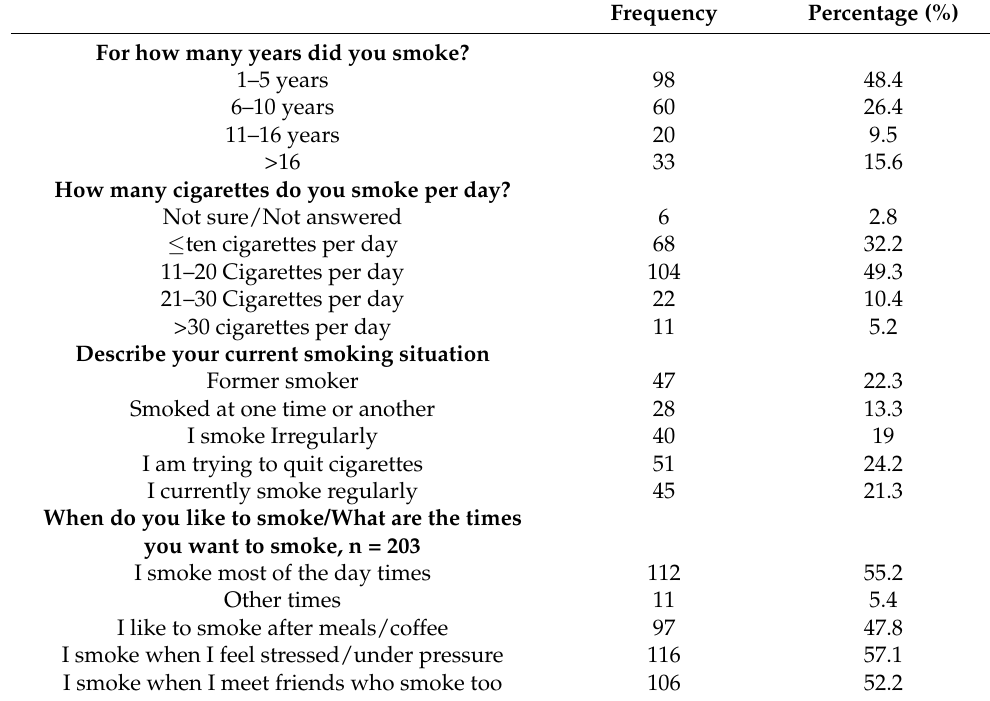
Table 3. Descriptive statistics of university students’ current and former smoking behavior, N =